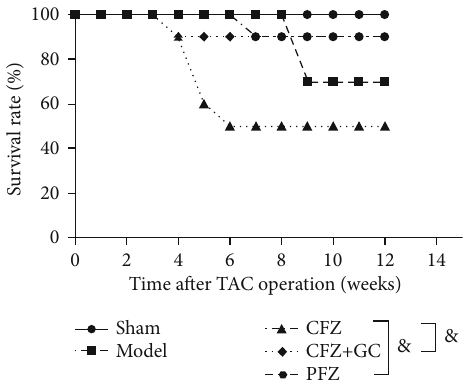
Figure 1: Survival rate of heart failure (HF) with di ff erent treatments. & P < 0 : 05 versus the crude Fuzi (CFZ)